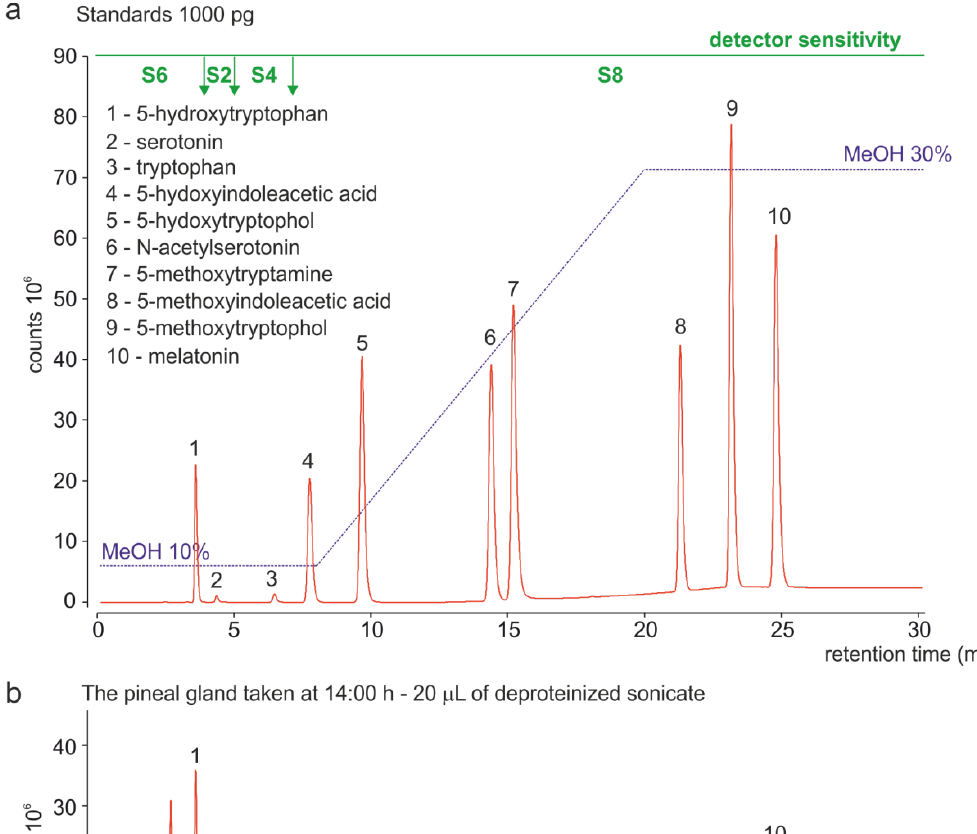
Figure 2. Chromatograms obtained using HPLC with fluorescence detection. ( a ) Separation of synthetic indoles applied as standards (1000 pg per injection); ( b ) Analysis of the duck pineal homogenate prepared from the organ taken at 14:00 h (20 µL per injection); ( c ) Analysis of the duck pineal homogenate prepared from the organ taken at 02:00 h (20 µL per injection). Green bar, switches of detector